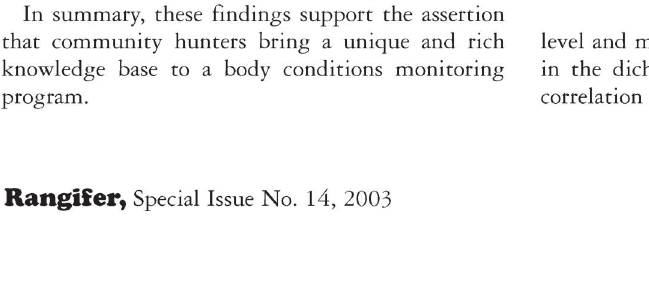
Fig. 2. Validation of Body Condition Class Structure using PCH